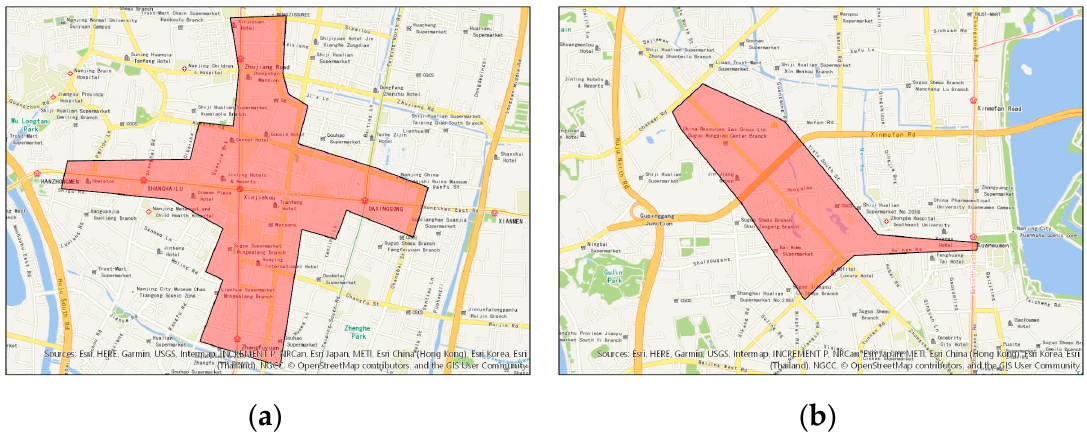
Figure 13. Prior range of commercial central districts: ( a ) Xinjiekou and ( b ) Hunan Road.